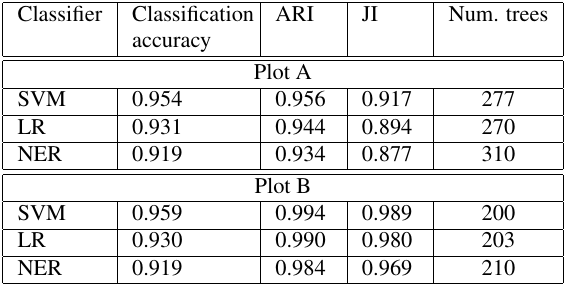
Table 3: Classifier with power transformation - results